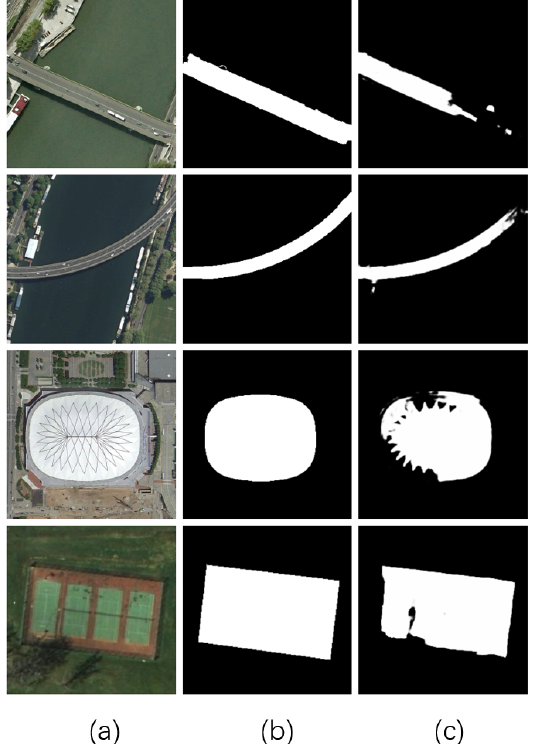
Figure 6. Some failure examples. ( a ) Optical RSIs. ( b ) Ground truth. ( c ) Saliency maps generated by our